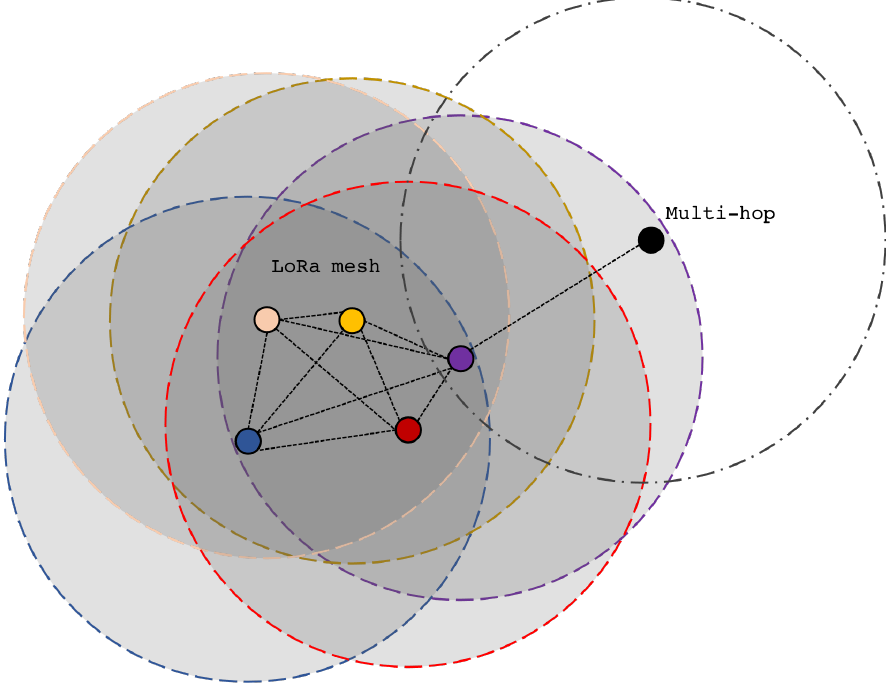
Figure 2. Peer-to-peer LoRa-based mesh network with multi-hop capabilities. Nodes are low-cost, low-power systems based on a microcontroller board embed- ding a LoRa chip. For our implementation we use the ESP32 Heltec WiFi LoRa V2 board (https://heltec.org/project/wifi-lora-32/ (accessed on 22 June 2021)), which comes with the Semtech SX1276 LoRa transceiver (https://www.semtech.com/products/wireless-rf/ lora-transceivers/sx1276 (accessed on 22 June 2021)) and costs around USD 20. Figure 3 shows a picture of the ESP32 Heltec WiFi LoRa V2 along with its external antenna, whose gain is 3